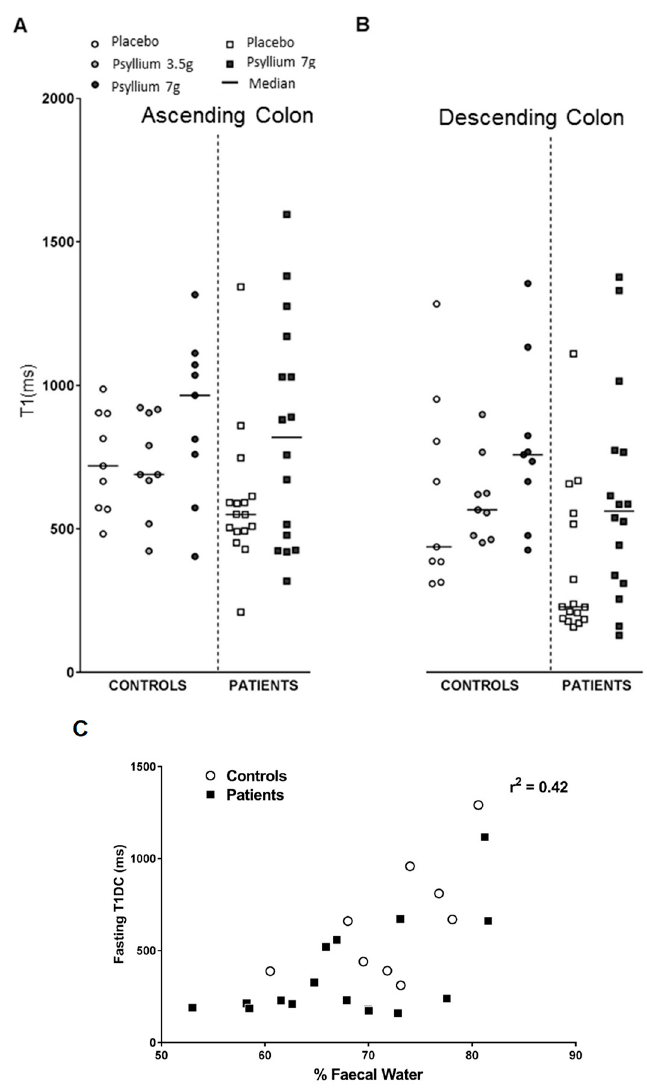
Figure 9. ( A ) Recovery of the longitudinal magnetization after a radiofrequency excitation (T1) values in ascending and ( B ) descending colons of healthy volunteers and constipated patients given psyllium 3.5 g or 7 g t.d.s. ( C ) Fasting T1 in descending colon and its correlation with % water as assessed by